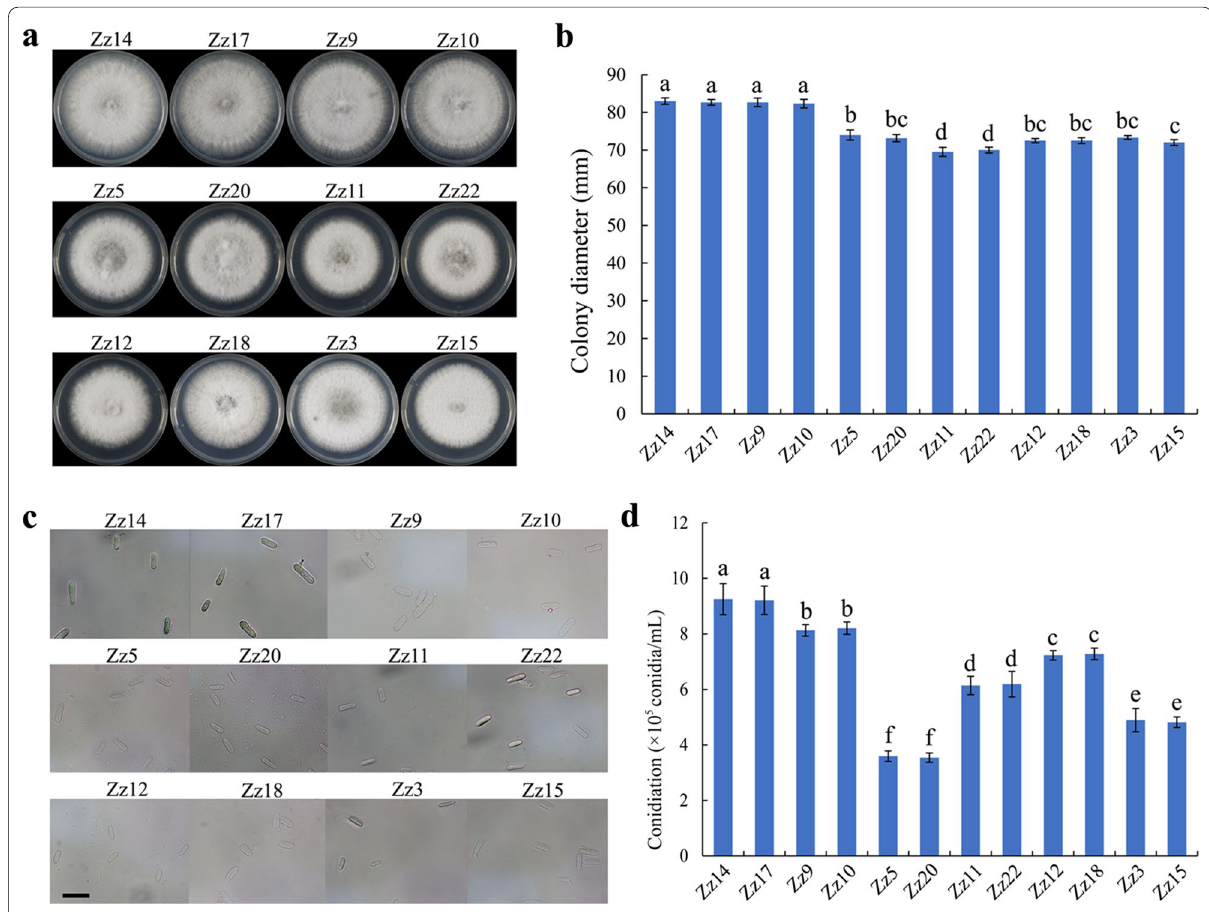
Fig. 3 Tebuconazole-resistant Colletotrichum siamense isolates are defective in mycelial growth and conidiation. a Mycelial growth of the tebuconazole-sensitive and tebuconazole-resistant isolates of C. siamense on PDA medium after 5 days of incubation at 25 °C in the dark. b Column diagram showing colony diameters of the tebuconazole-sensitive and tebuconazole-resistant isolates of C. siamense on PDA medium after 5 days of incubation at 25 °C. Error bars denote the standard deviations from three repeats. Different letters indicate significant differences according to the Fisher’s LSD test at P 0.05. c Conidial morphology of the tebuconazole-sensitive and tebuconazole-resistant isolates of C. siamense . Bar 20 µm. = = d Conidiation capacity of the tebuconazole-sensitive and tebuconazole-resistant isolates of C. siamense. Conidial production was quantified after incubation in 30 mL PDB medium for 5 days at 25 °C. Error bars denote the standard deviations from three repeats. Different letters indicate significant differences according to the Fisher’s LSD test at P =